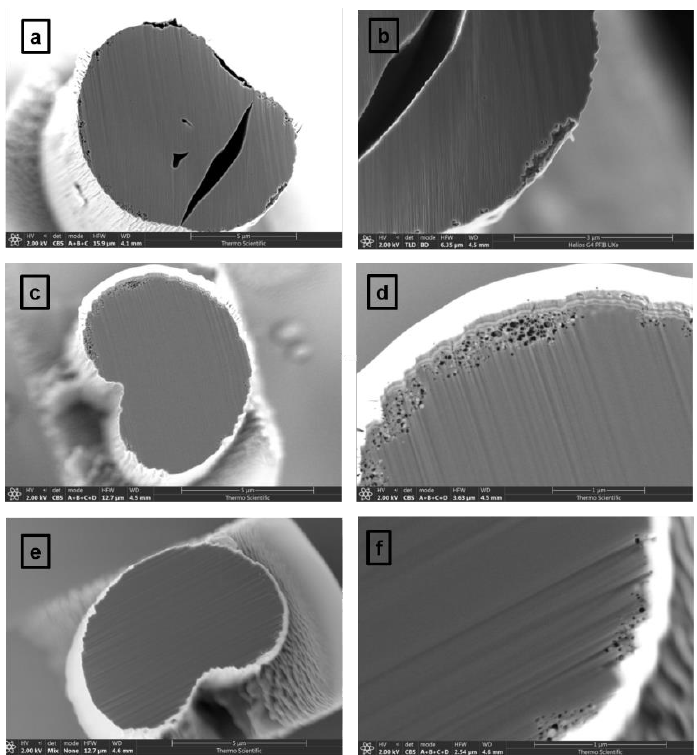
Figure 2. Cross-sectional SEM images, at different resolutions, of carbon fibers: ( a , b ) sample 1 exposed to a thermal stabilization process (225 – 285 °C); ( c , d ) sample 2 carbonized to low temperatures (450 – 950 °C); and ( e , f ) sample 3 carbonized to high temperatures (1000 – 1500 °C).